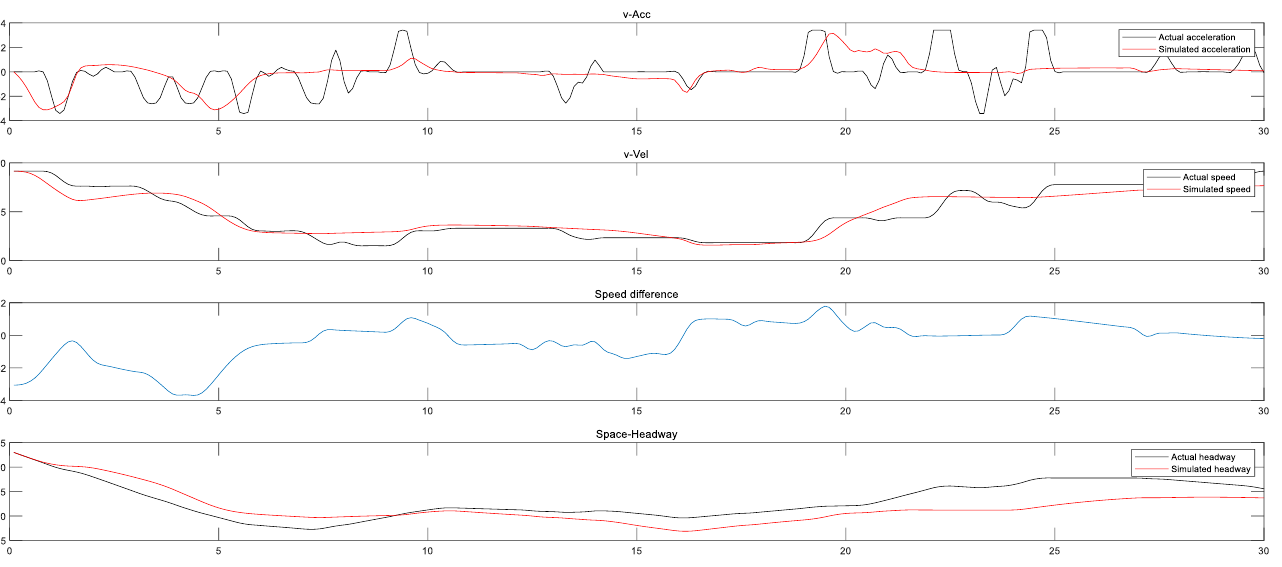
Figure 11. Simulation results of the GA-BP fitted stimulus-response model.